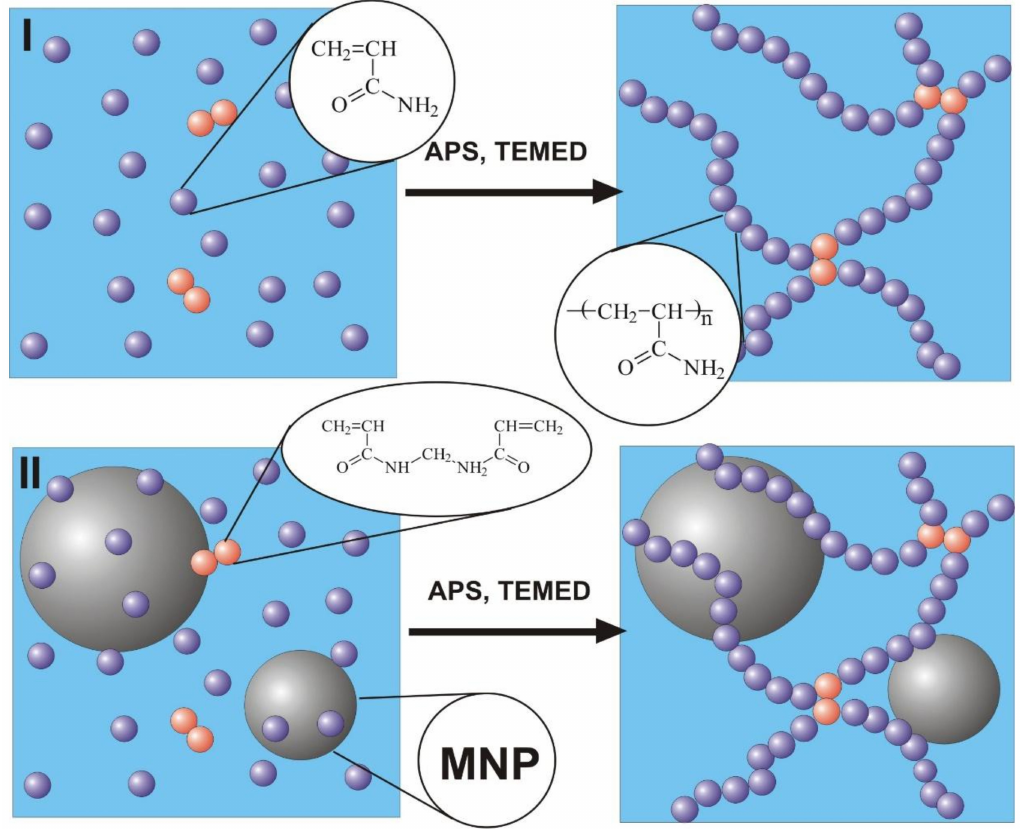
Figure 1. Schematic presentation of gel preparation ( I ) and ferrogel preparation ( II